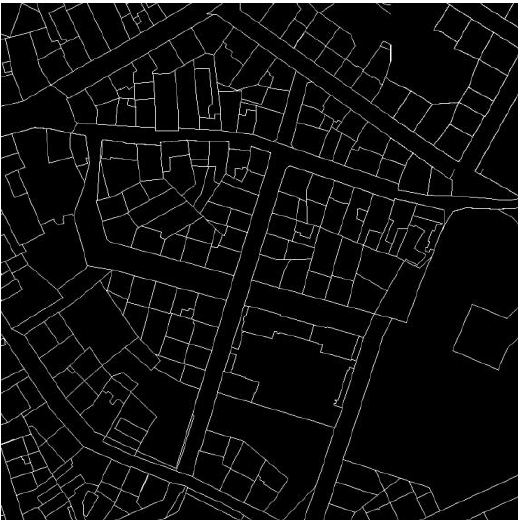
Figure 4. Cadastral map of Graz with legal property boundaries is shown for the same area in Figure 3. The original data is in vector format that has been converted to a raster image at a GSD of 10 cm. Shown are 300 separate parcels [Courtesy of